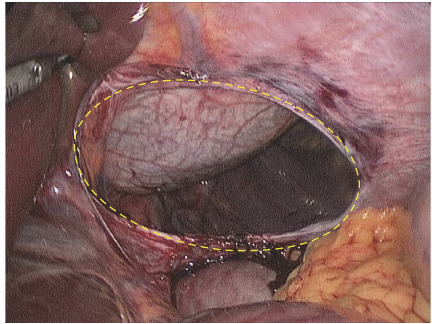
Figure 5: Laparoscopic view showing the diaphragmatic defect (outlined by dashed yellow